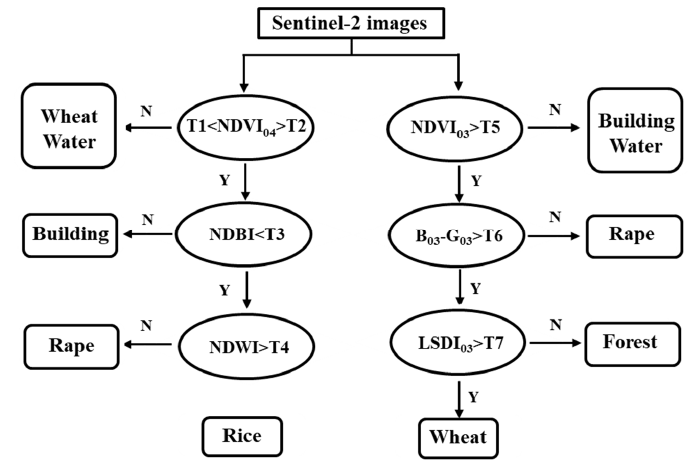
Figure 9. Decision tree for crop classification on the middle-lower Yangtze River plain. T1-7 represent the threshold values of each procedure with slight differences among the subregions.